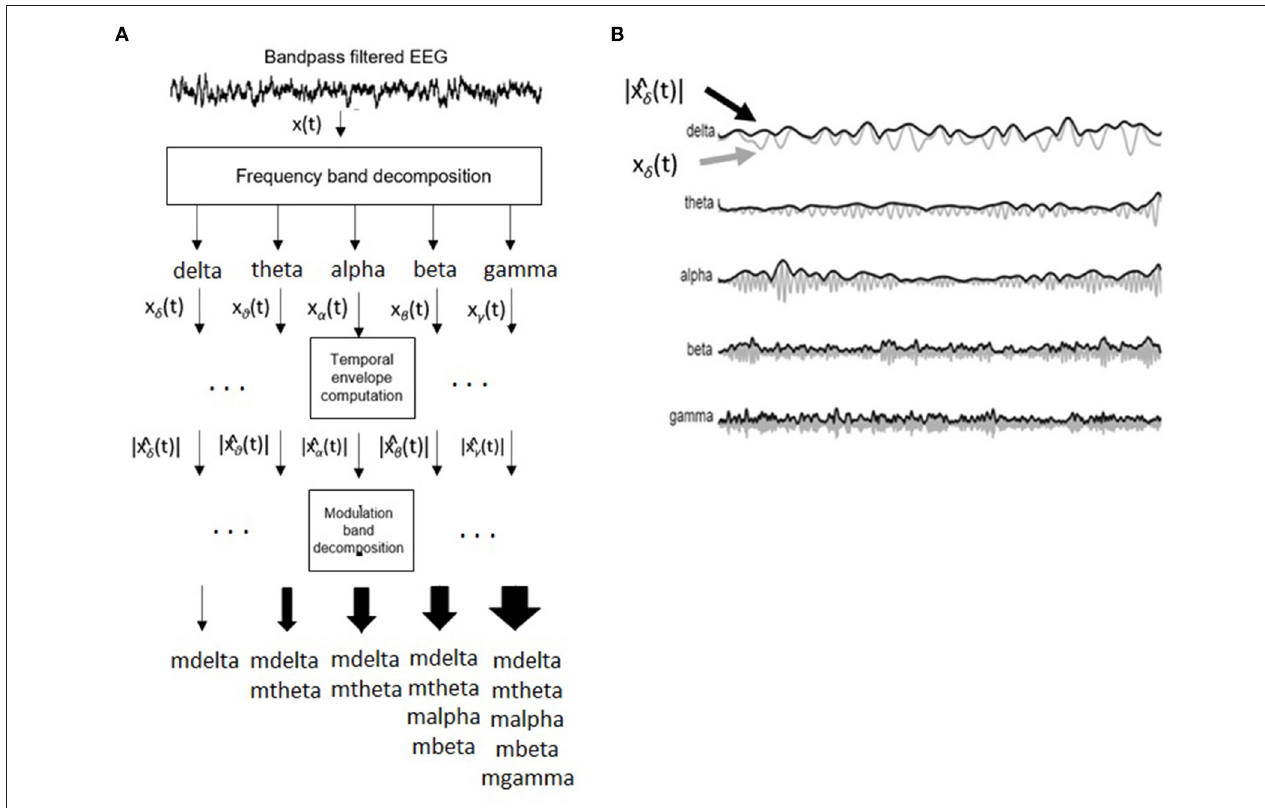
FIGURE 3 | (A) Signal processing steps involved in computation of amplitude modulation rate-of-change features. (B) Bandpass filtered EEG signals and their time envelopes. Adapted from Falk et al. (2012).